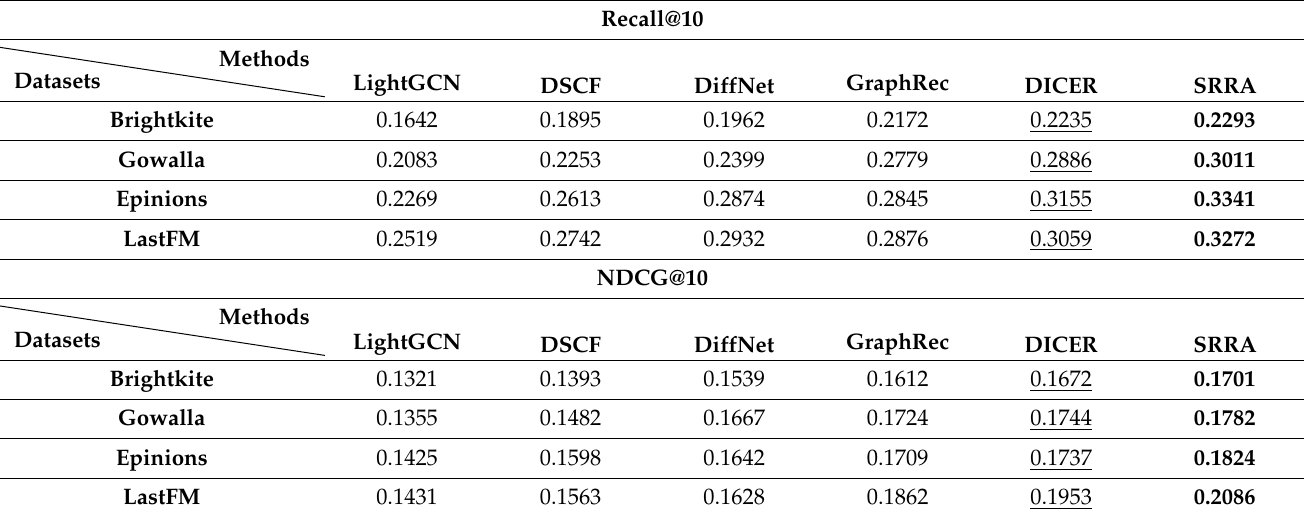
Table 3. Performance comparison between SRRA and baselines.